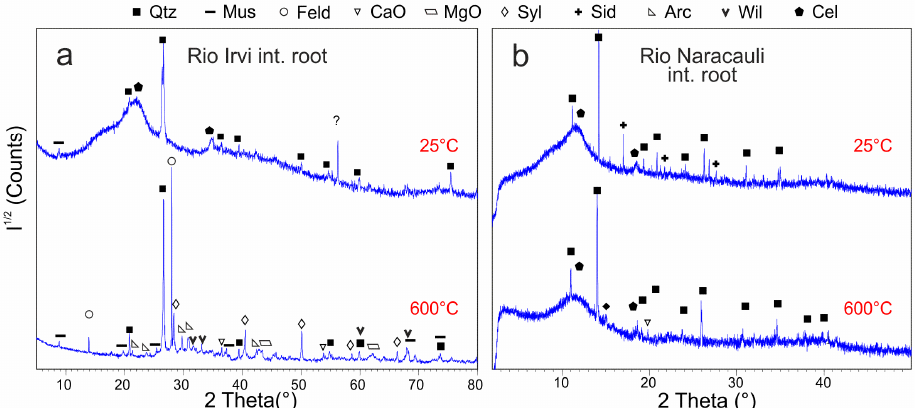
Figure 8. XRD patterns showing the effect of ex-situ heating on internal root samples from Rio Irvi ( a ) and in-situ heating on internal root samples from Rio Naracauli ( b ). Intensities (I 1 / 2 ) are reported in a square root scale. Abbreviations as in Tables 2 and 3.